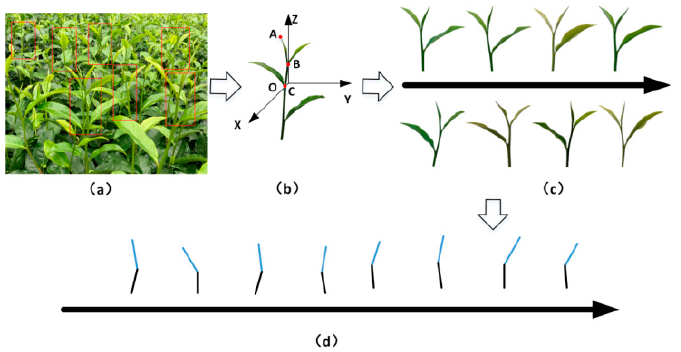
Figure 3. Scene graph of the tea leaf ( a ), coordinate system of a single tea leaf ( b ), various forms of the tea leaf( c ) and the diagram of the tea trunk ( d ).